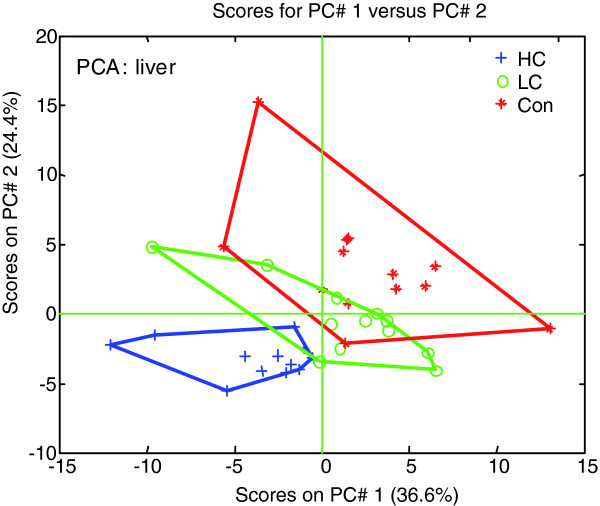
Lipidom analysis of liver homogenates (n = 10 per group). Score plot was derived from PCA. The two component model explained 36.6% (principle component 1; PC# 1) and 24.4% (PC# 2) of the variation in the data.